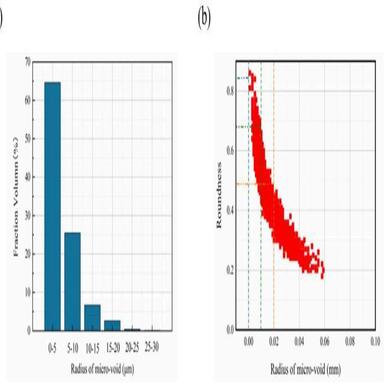
The statistical data of micro-voids in AA2024-T3: (a) distribution histogram of micro-void diameter and (b) relationship between radius and roundness.